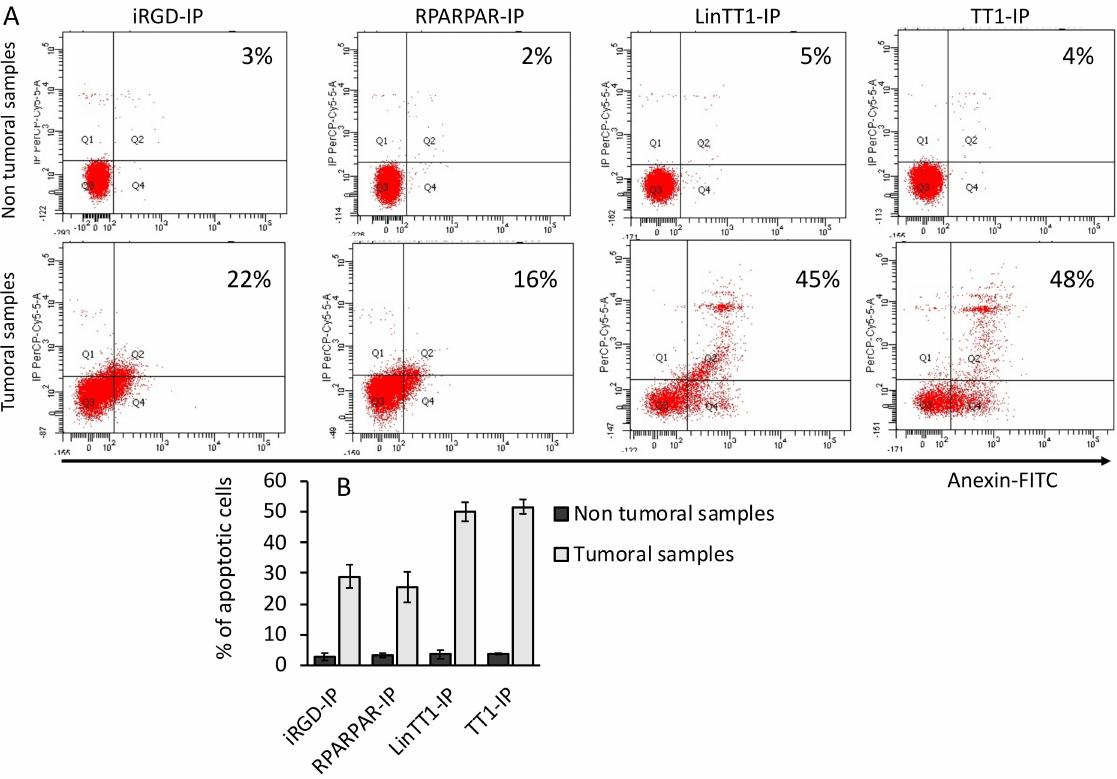
Figure 6. TPP-IPs induce apoptosis in HCC. Hepatocytes isolated from HCC (patient 7) or non-malignant tumors (patient 1) were cultured 12 h with 25 µ M and the resulting apoptosis was estimated by annexin-V-FITC staining using flow cytometry. ( A ) Flow cytometry plots from one non-tumoral (patient 1) and one tumoral sample (patient 7). ( B ) Quantification of the percentage of apoptotic cells from three non-tumoral and three tumoral samples. Error bars = ± standard